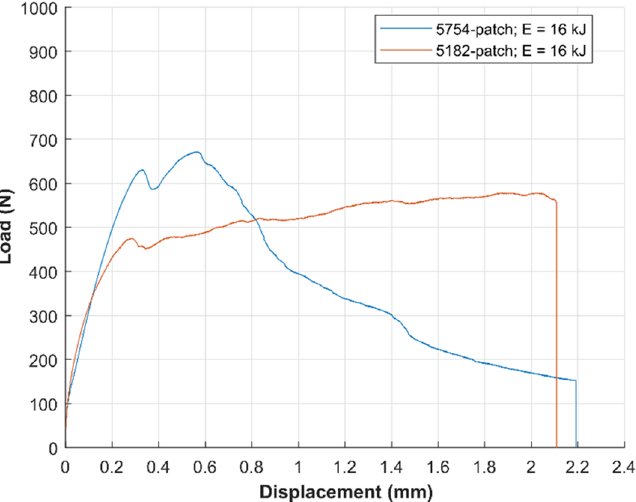
Figure 18. Load vs. displacement curves of quasi-static tests for joints between composite and DC04 steel using the patch configuration.